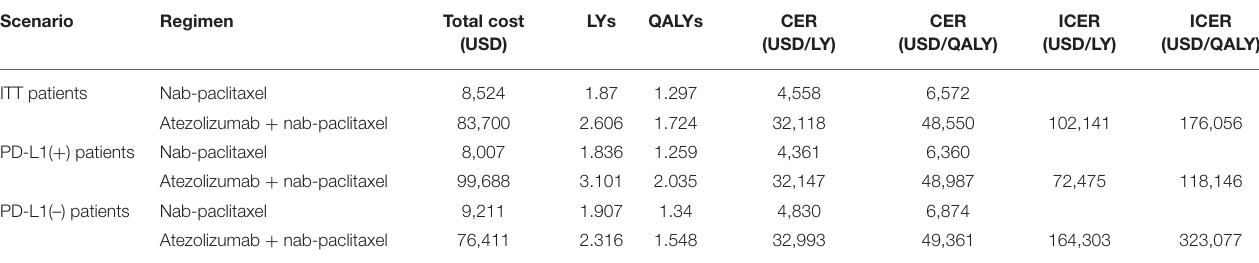
TABLE 2 | Results of the base-case analysis.